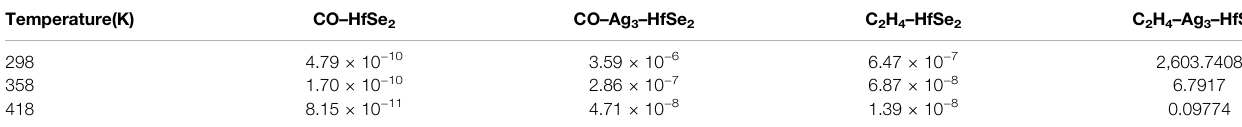
TABLE 3 | Desorption time (s) of the adsorbed gas under different test temperatures. Temperature(K)